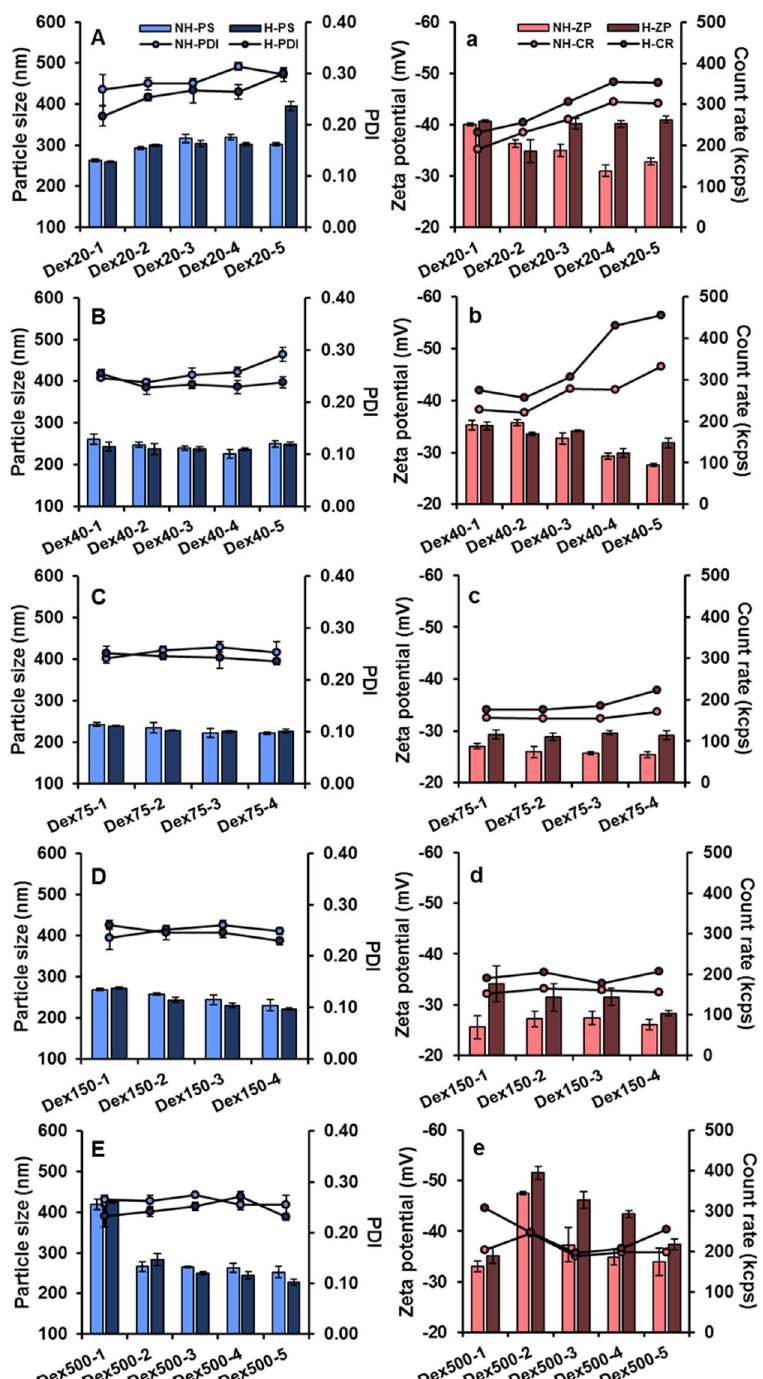
Figure 5. Particle size, PDI ( A–E ), zeta potential, and count rate (a–e) of pectin-coated LPN (before and after thermal treatment) prepared using Maillard conjugates with different molecular weight dextran. The groups Dex75-5 and Dex150-5 formed gels and were not completely solubilized in water, and thus their results were excluded. NH: non-heat, H: heat, PS: particle size, ZP: zeta potential, CR: count